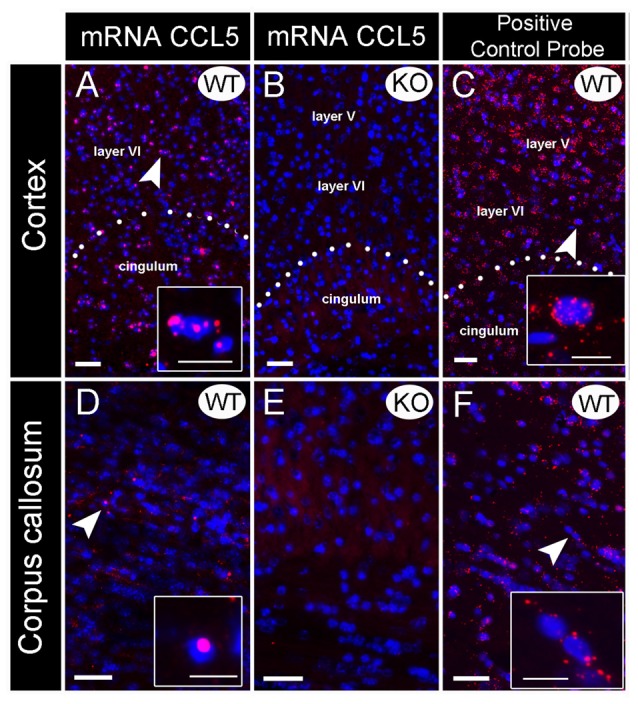
Validation of CCL5 mRNA probe using CCL5 knock-out (KO) mice. In situ hybridization was performed with an RNAscope probe targeting CCL5 mRNA. Representative images for CCL5 mRNA (red dots) and nuclei counterstained with DAPI (blue) in the cortex (A–C) and corpus callosum (D–F) of wild-type (WT) (A,D) and KO (B,E) mice. The sections were also analyzed for peptidylprolyl isomerase B mRNA (C,F) as positive control probe. Insets: high magnification images depicted by the white arrows. Images showed that the fluorescent in situ hybridization by the RNAscope probe produces puncta (red dots) that represents a single mRNA transcript. Scale bar 50 μm for (A–F) and 20 μm for inset images.